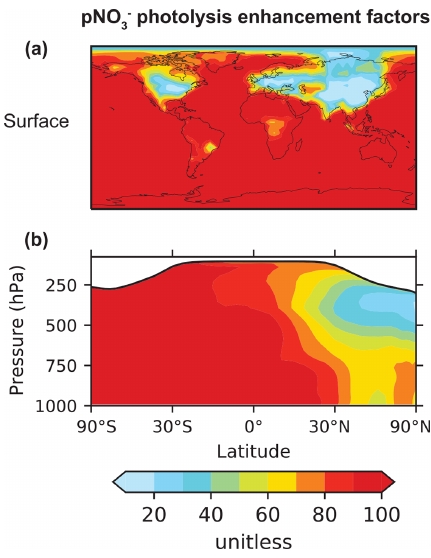
Figure 5. Annual mean (2015) enhancement factors (EFs) for the photolysis frequency of p NO − with respect to the photolysis 3 frequency of HNO 3 in our baseline simulation. Panel (a) shows EFs at the surface, and panel (b) shows the zonal mean EFs. The EF for fine p NO − varies from 10 to 100, according to Eq. (1), 3 and that for coarse p NO − is set at 100. The values shown here 3 are the concentration-weighted average EFs for total (fine plus coarse) p NO − . The zonal mean EFs are calculated as p NO − 3 3 concentration-weighted averages for the band of grid cells in each altitude and latitude bin. The white shading in the zonal mean plots denotes the